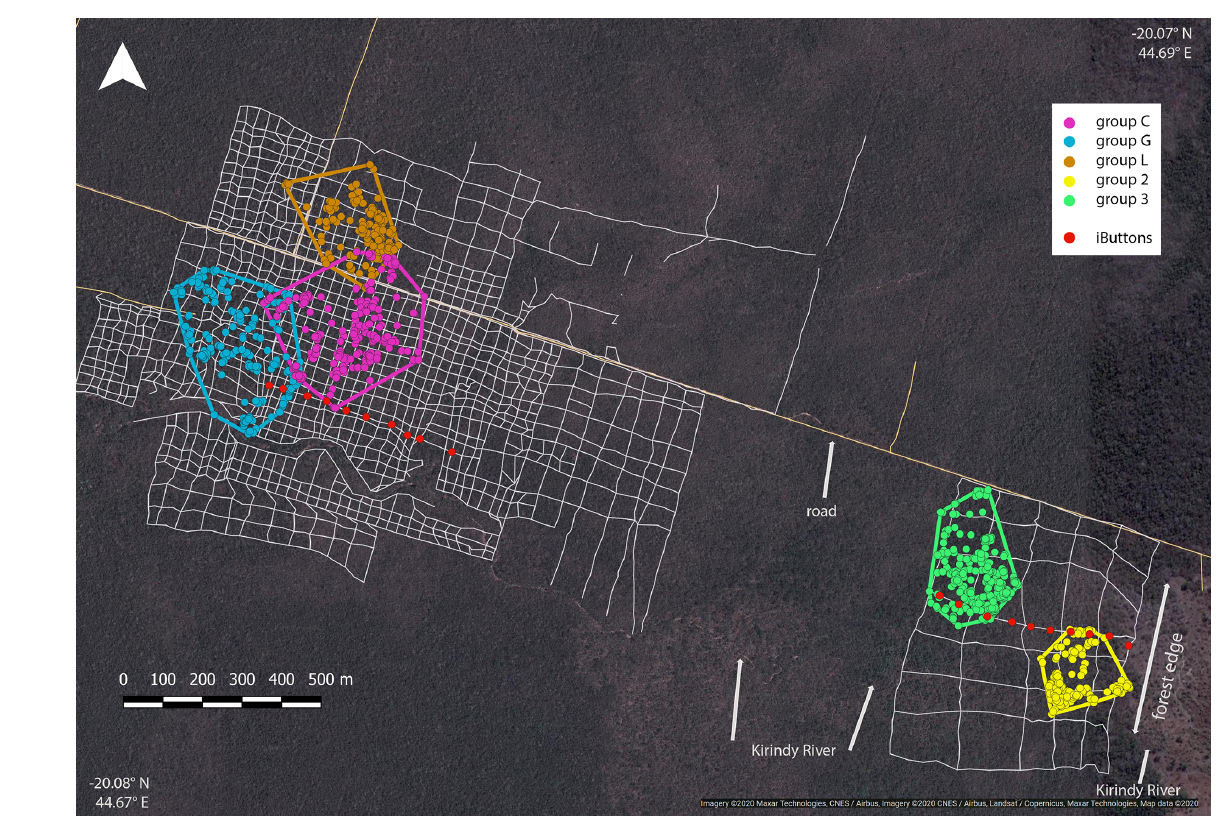
Figure 1. Satellite image of the study area depicting the home ranges of the study groups in the interior (groups C, G and L) and at the edge (groups 2 and 3) with MCPs (minimum convex polygons), the grid system of small foot trails (grey lines), and iButton locations (red dots).